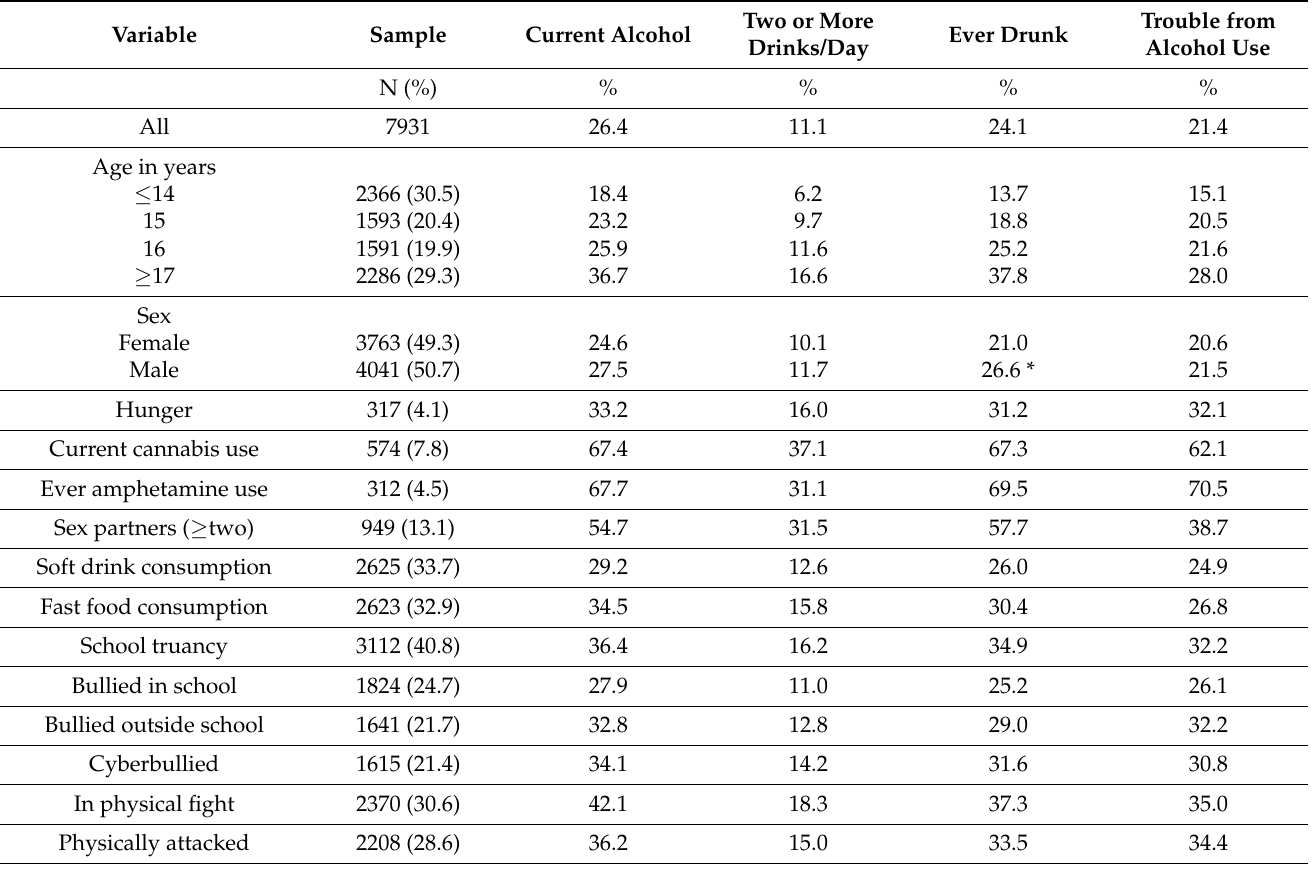
Table 2. Descriptive results, school adolescents, Bolivia,